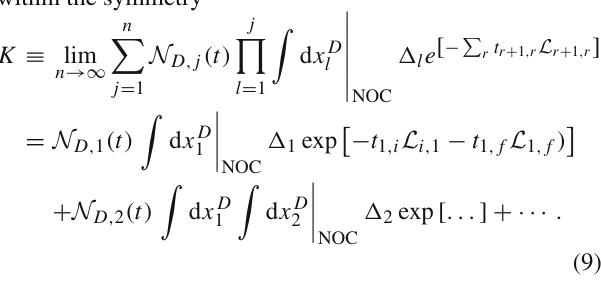
Fig. 2 Non-relativistic PI in three dimensions with equivalent inter- mediate points x